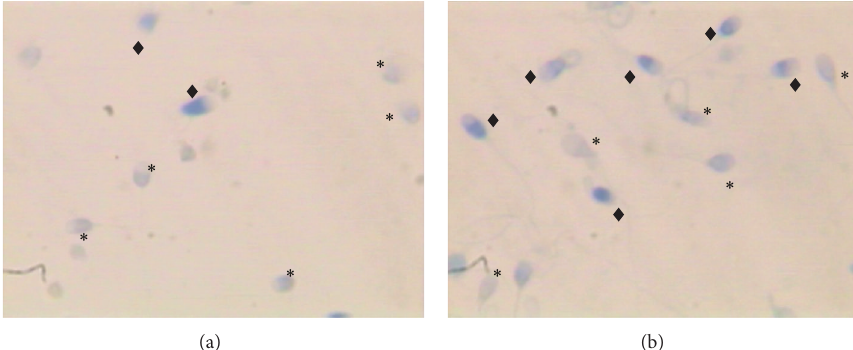
Figure 1: Sperm chromatin condensation assessed by aniline blue. (a) Sample showing mainly mature sperm with unstained nucleus ( ∗ ). (b) Sample showing mainly immature sperm ( ⧫ ) with blue-stained nucleus.